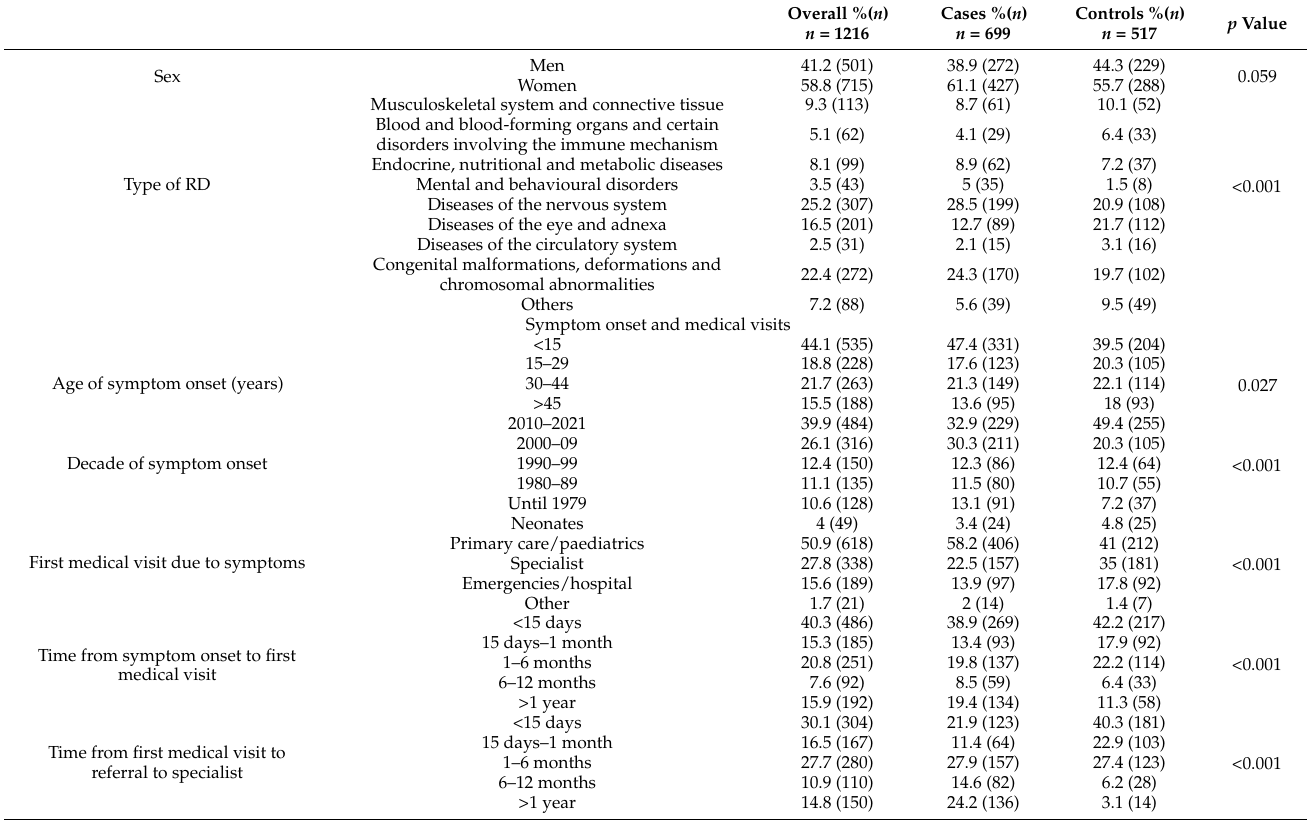
Table 1. Diagnostic process of people living with an RD in